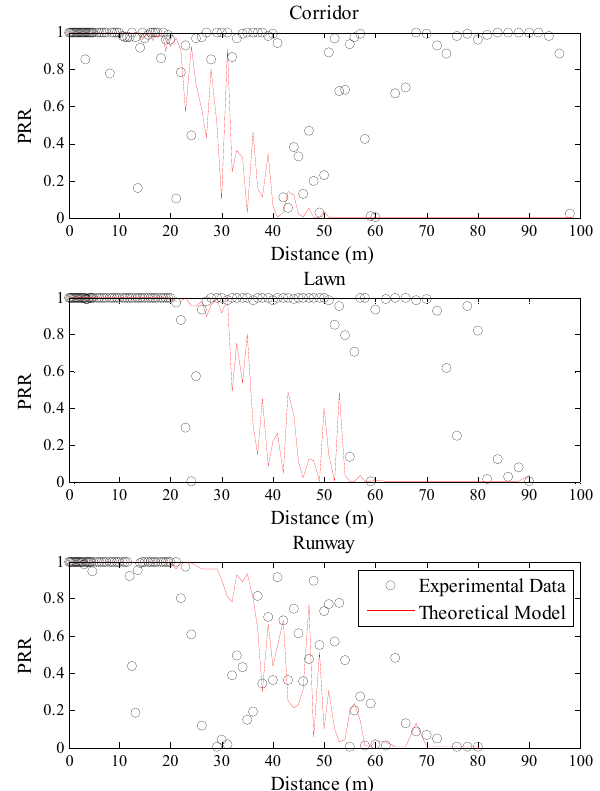
Table 3. The root mean square errors (RMSEs) of the mapping models in different environments.